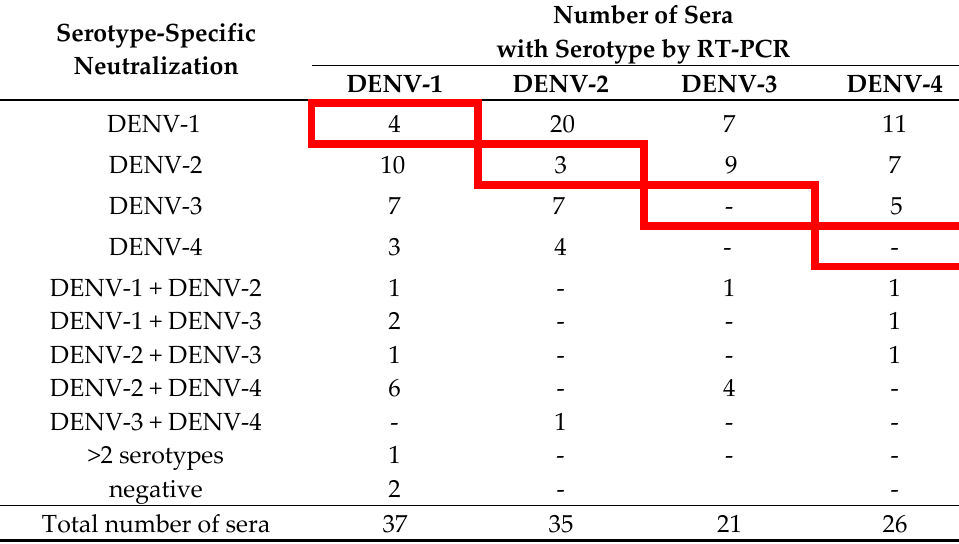
Serotype-Specific Neutralization